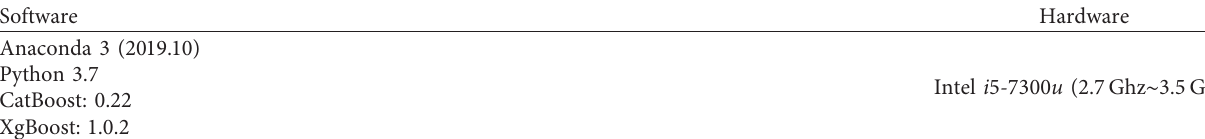
Table 3: Hardware and software environment for the experiment.